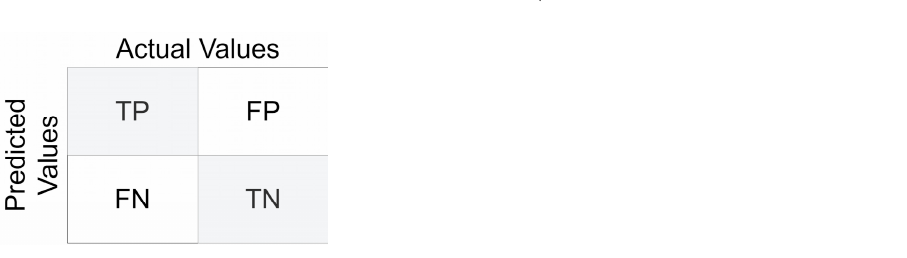
Figure 12. Confusion matrix.